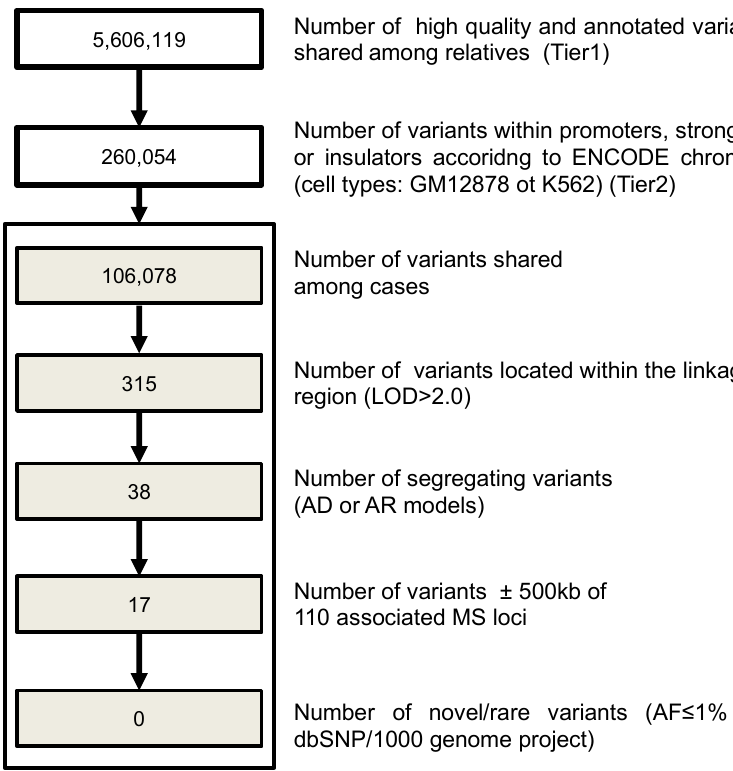
Figure 2. Pipeline applied for regulatory variant filtering. The different steps used to filter regulatory genetic variants and the number of left variants in the family are reported. AF: allele frequency; AD: autosomal dominant; AR: autosomal recessive.